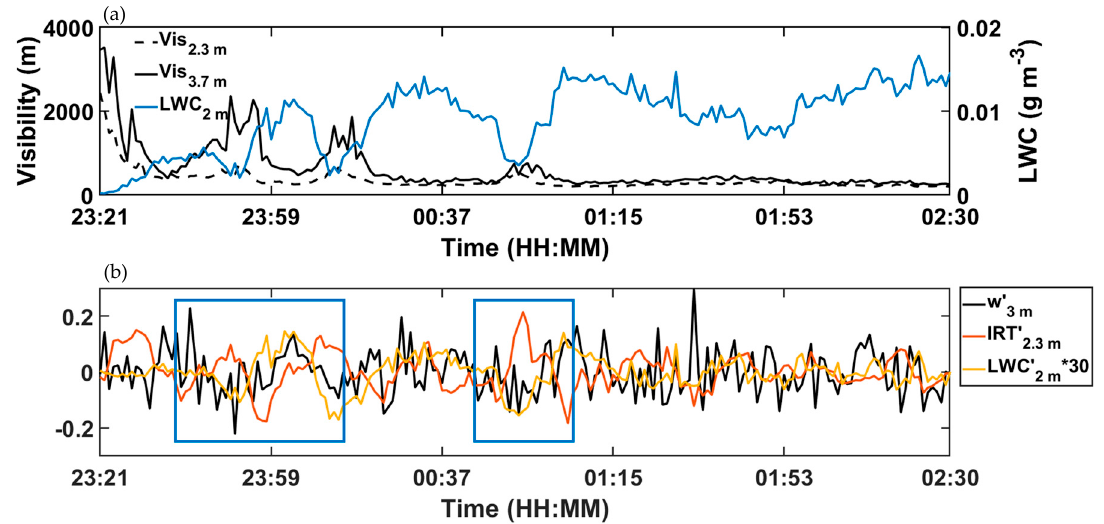
Figure 8. The time series of ( a ) visibility at 2.3 m (dashed line), 3.7 m (solid line), and LWC at 2 m (blue); ( b ) w (cid:4593) at 3 m (black), IRT (cid:4593) at 2.3 m (brown), and LWC (cid:4593) at 2 m (yellow) averaged over 1 min for 2321 08 October 2017 - 0230 09 October 2017 in case 4. The blue rectangles show that w (cid:4593) and IRT (cid:4593) and IRT (cid:4593) and LWC (cid:4593) tend to be negatively correlated.